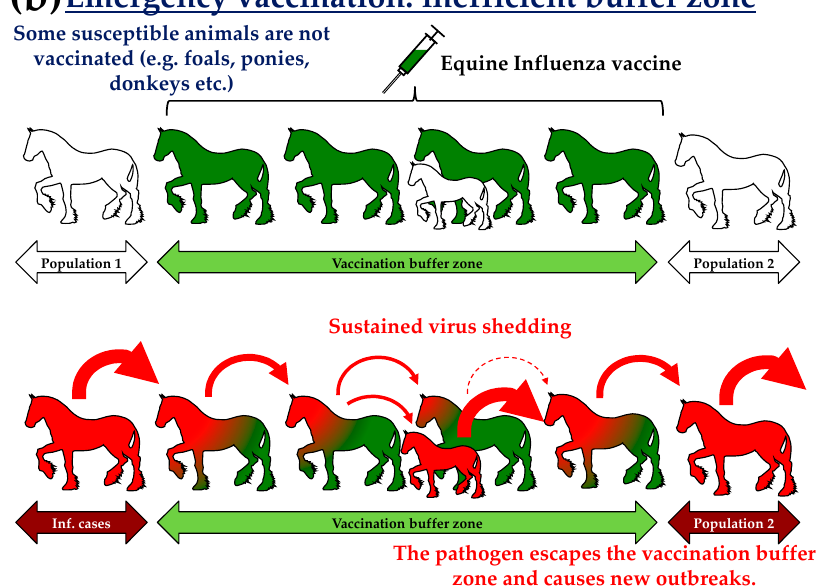
Figure 1. Emergency vaccination; ( a ) efficient or ( b ) inefficient vaccination buffer zone. The age to vaccinate foals against equine influenza A virus (EIV) is variable and will depend of the EI vaccine used (i.e., usually from 4 to 11 months of age for most Equine Influenza (EI) vaccines commercialized) and the presence of maternal-derived antibody (if the mare was vaccinated during pregnancy).